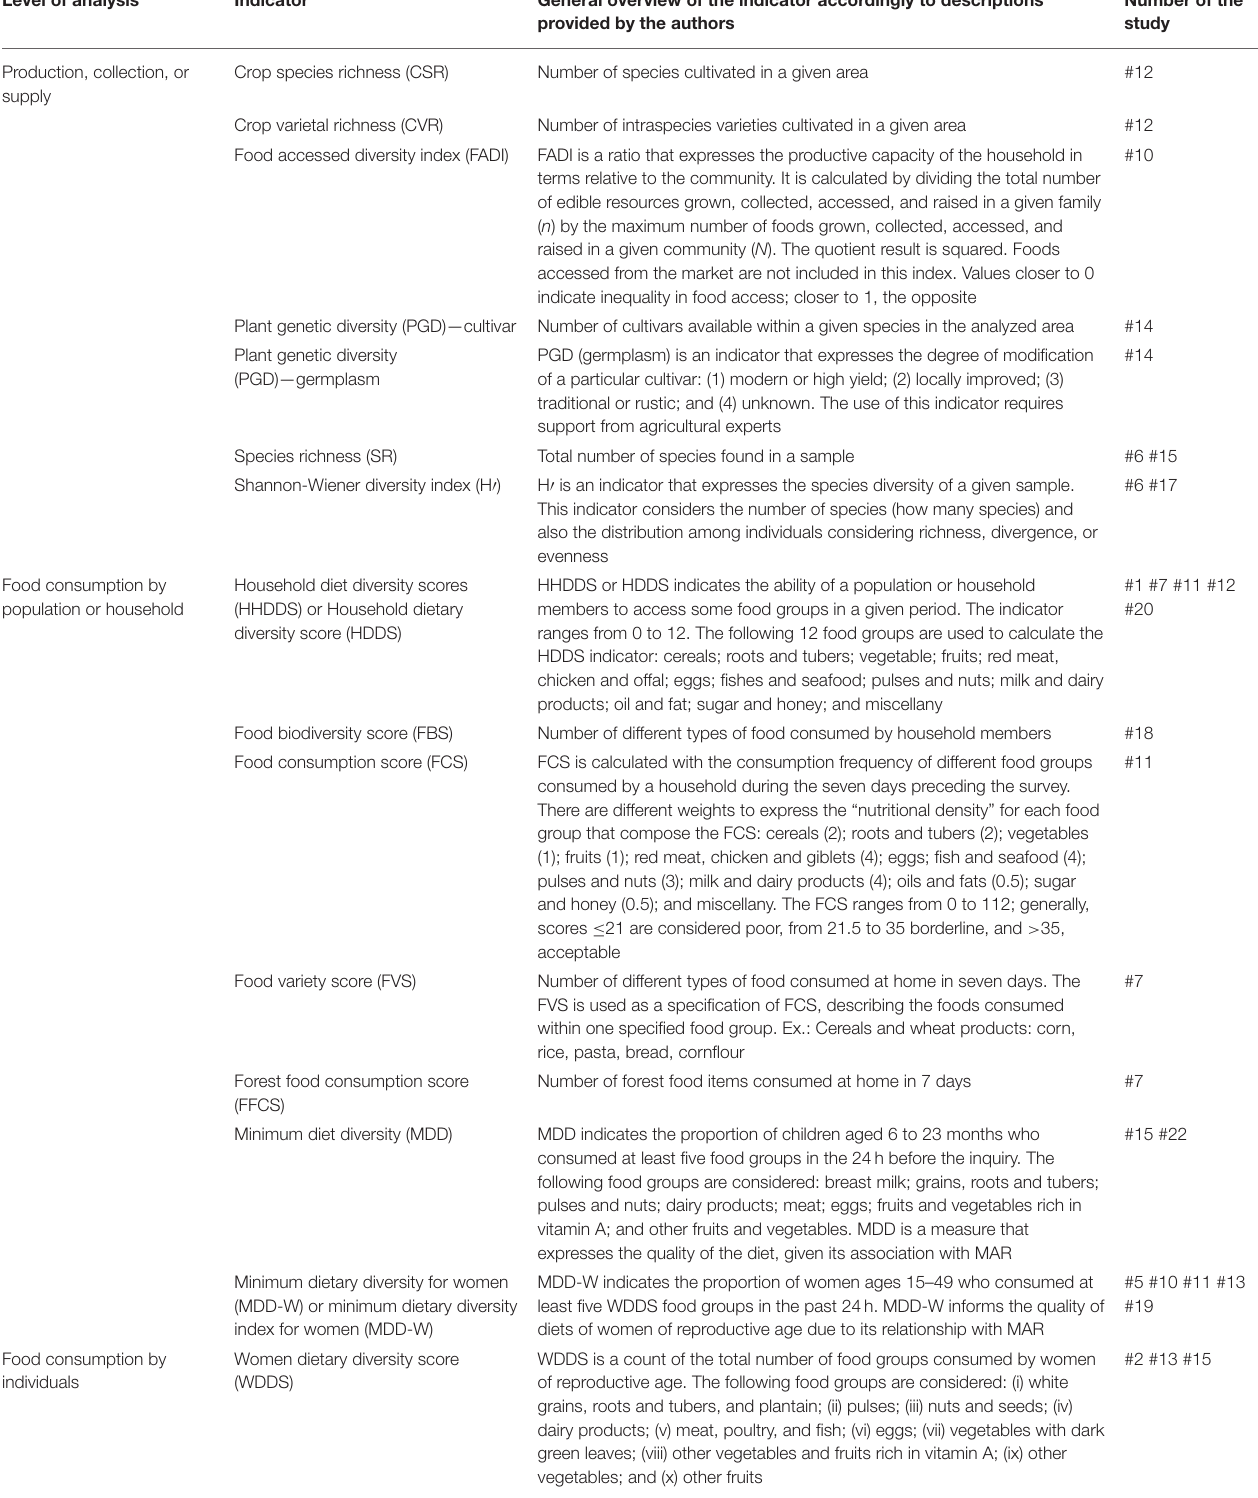
TABLE 3 | Summary of indicators employed to measure the contribution of biodiversity to nutrition in food consumption